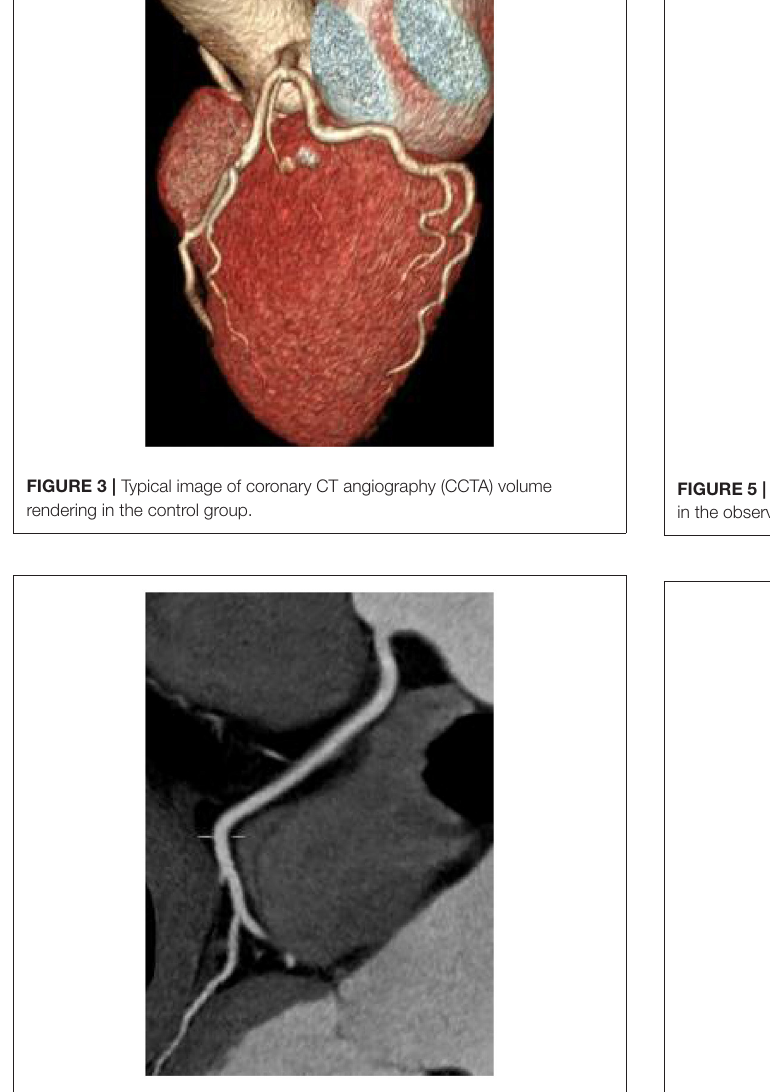
FIGURE 6 | Typical image of CCTA volume rendering in the observation